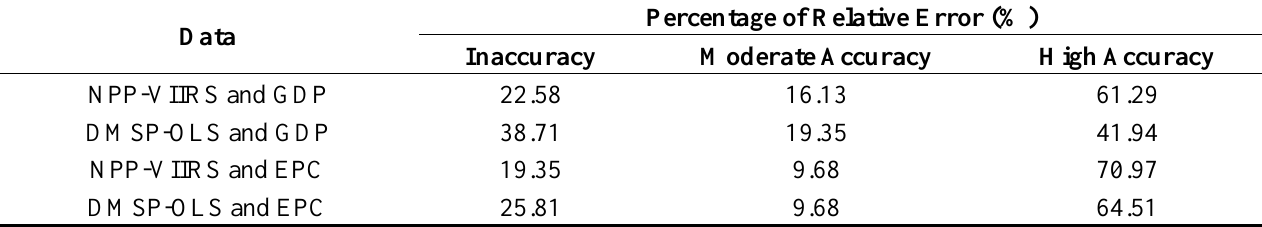
Table 2. Different classes of predicted accuracies for the gross domestic product (GDP) and electric power consumption (EPC) at provincial